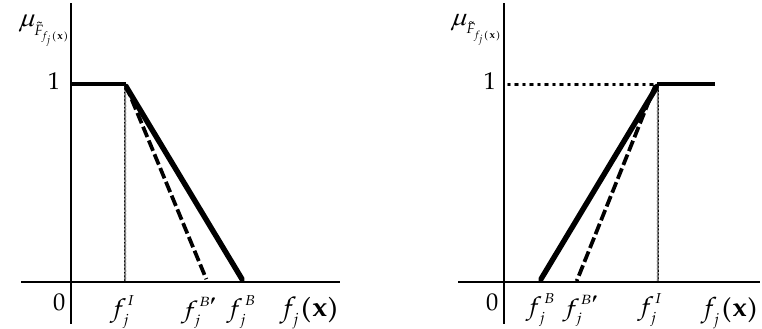
Figure 2. Modification of minimizing ( left ) and maximizing ( right ) fuzzy goals.